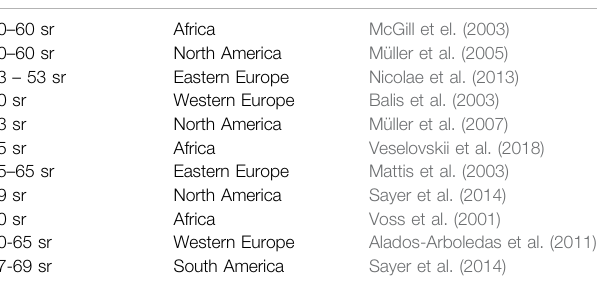
TABLE 4 | Previously published smoke lidar ratio values from various